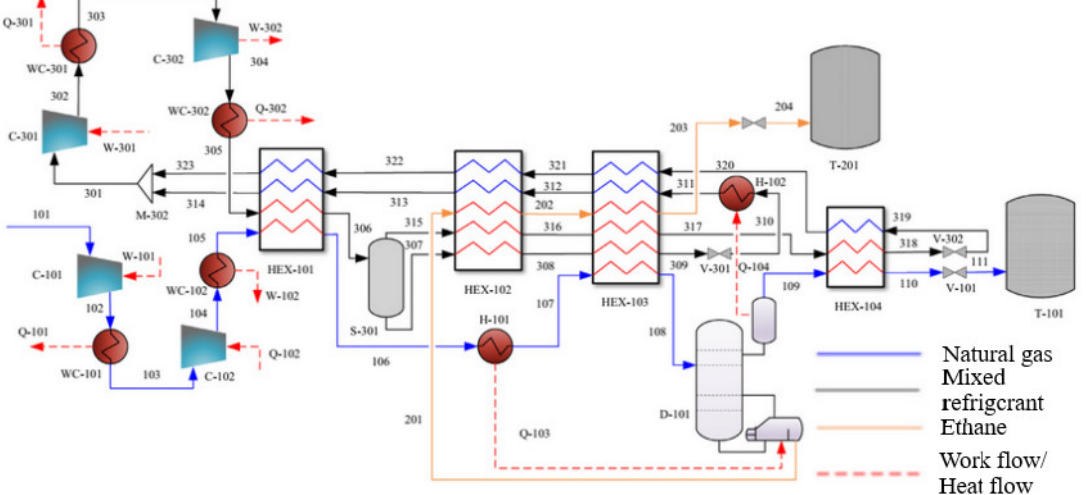
Reproduced with permission from International Journal of Refrigeration. Figure 45. Simplified Process 1 for FLNG [174].